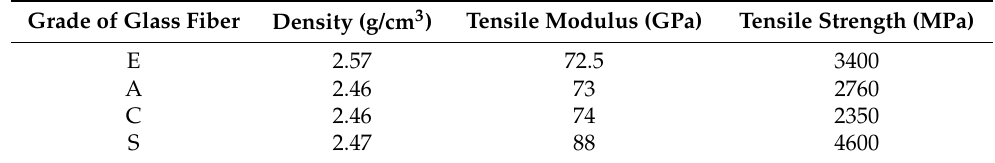
Table 1. Approximate properties of common grades of glass fibers which adapted from [46] © 2023 by John Wiley & Sons, Inc. Grade of Glass Fiber Density (g/cm 3 ) Tensile Modulus (GPa) Tensile Strength (MPa) E 2.57 72.5 3400 A 2.46 C 2.46 74 2350 S 2.47 88